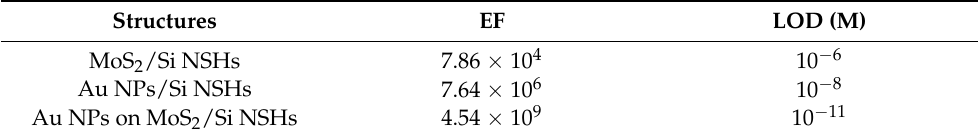
Figure 5. SERS signals of solutions of R6G at concentrations from 10 –8 to 10 –12 M on the few-layer MoS 2 decorated with Au NPs on Si NSHs substrates. The curve REF is the SERS data for the planar Si in the presence of 10 –2 M R6G, for comparison. Table 1. The EF and LOD values obtained by using MoS 2 /Si NSHs, Au NPs/Si NSHs and MoS 2 decorated with Au NPs on Si NSHs as SERS